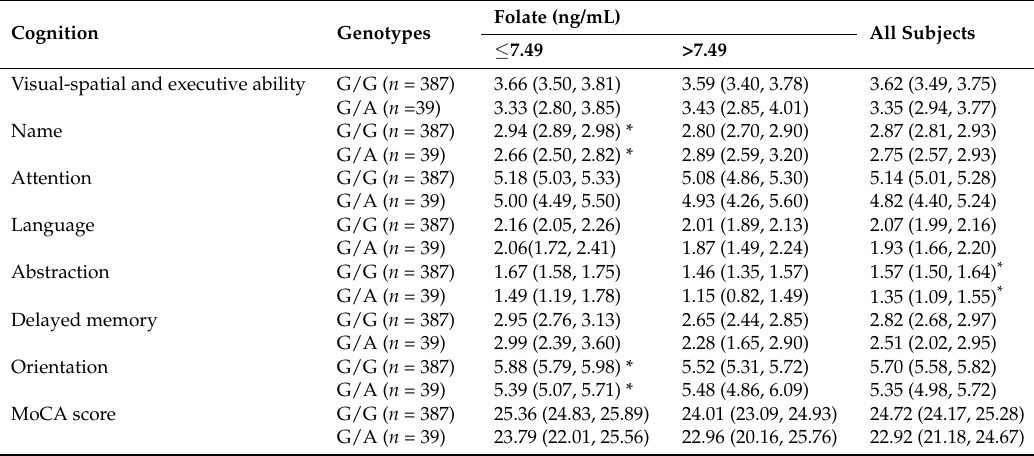
Table 5. MoCA scores by serum folate level and MTHFR G1793A genotypes. Cognition